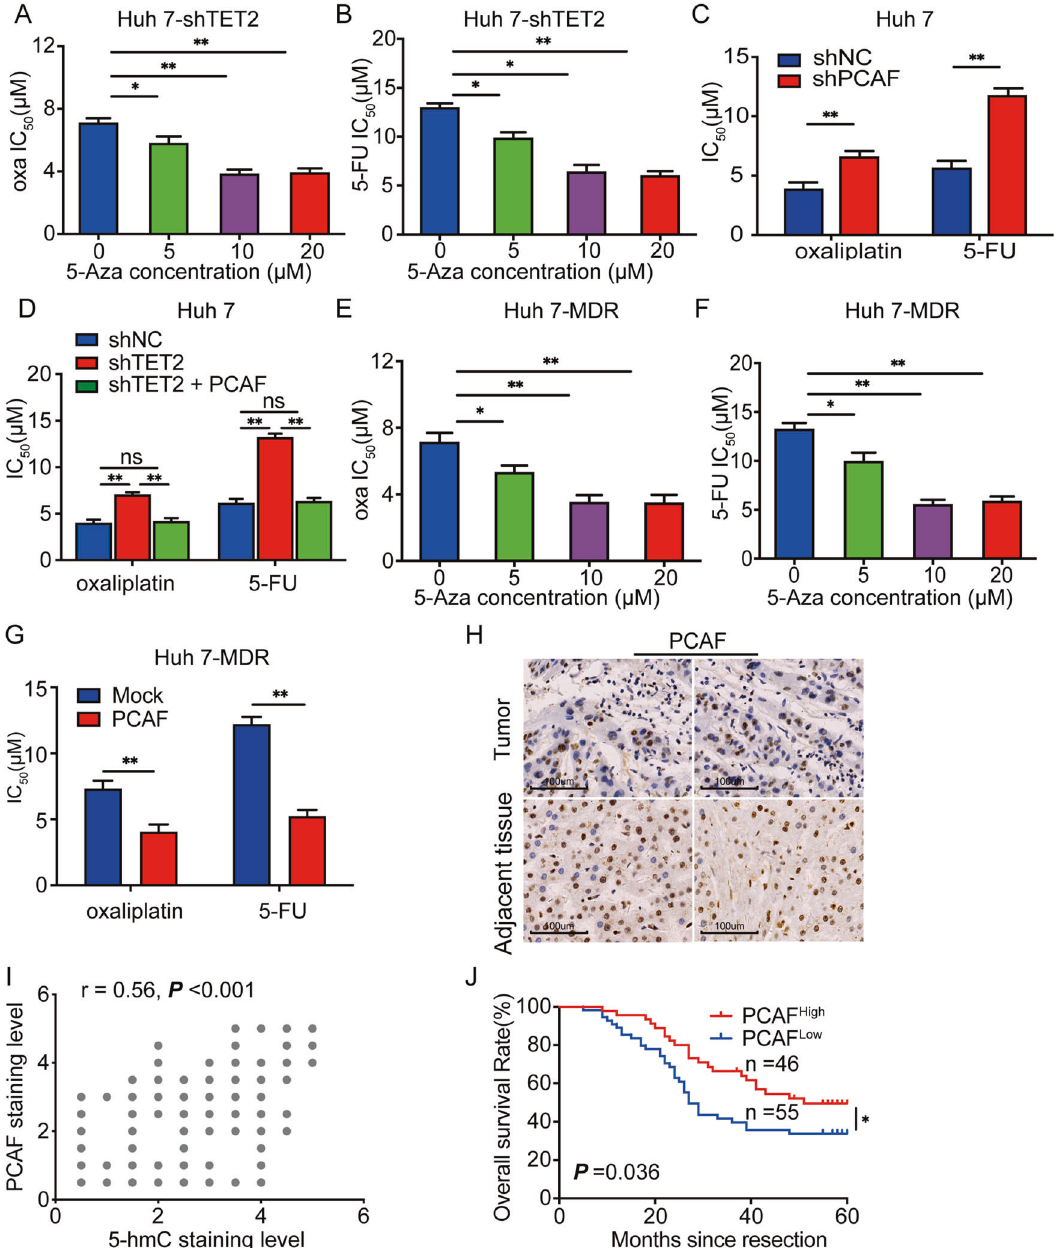
Fig. 4 Chemotherapy resistance induced by TET2-knockdown depends on PCAF inhibition. A CCK-8 assay showing IC50 of oxaliplatin in Huh 7-shTET2 cells treated with different concentrations of 5-aza; n = 3, One-way ANOVA, * P < 0.05; ** P < 0.01. B CCK-8 assay showing 5-FU IC50 in Huh 7-shTET2 treated with different concentrations of 5-aza; n = 3, One-way ANOVA, * P < 0.05; ** P < 0.01. C CCK-8 assay showing chemotherapy sensitivity in Huh 7 cells with knockdown of PCAF; n = 3; t test, ** P < 0.01. D CCK-8 assay showing chemotherapy sensitivity in Huh 7-shTET2 cells with forced expression of PCAF; n = 3; One-way ANOVA, ** P < 0.01. E CCK-8 assay showing oxaliplatin IC50 in Huh 7-MDR cells treated with different concentrations of 5-aza; n = 3; One-way ANOVA, * P < 0.05; ** P < 0.01. F CCK-8 assay showing 5-FU IC50 in Huh 7-MDR cells treated with different concentrations of 5-aza; n = 3; One-way ANOVA, * P < 0.05; ** P < 0.01. G CCK-8 assay to assess the chemotherapy sensitivity of Huh 7-MDR cells with forced expression of PCAF in vitro; n = 3; t test, ** P < 0.01. H Representative immunostaining images of PCAF in tumor tissue and adjacent liver tissue in HCC patients. I A positive correlation between the level of 5-hmC and PCAF expression was observed in HCC tissues; Spearman rank correlation, r = 0.56; P < 0.001. J Overall survival analysis of PCAF expression in 101 HCC patients; Log-rank test, P = 0.036. All data are presented as mean ± SD; n = 3. * P < 0.05; ** P < 0.01. 5-hmC High group (hazard ratio: 1.780; 95% con fi dence interval: 1.198 – 2.644; Log-rank test, P = 0.004) (Fig. 7A). Further, we found that patients with low 5-hmC levels had a signi fi cantly higher